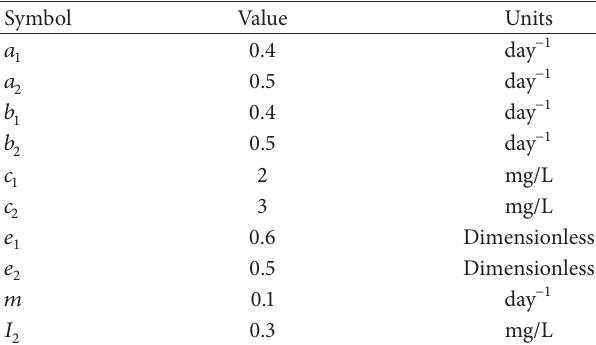
Table 1: Parameter values of system (1).